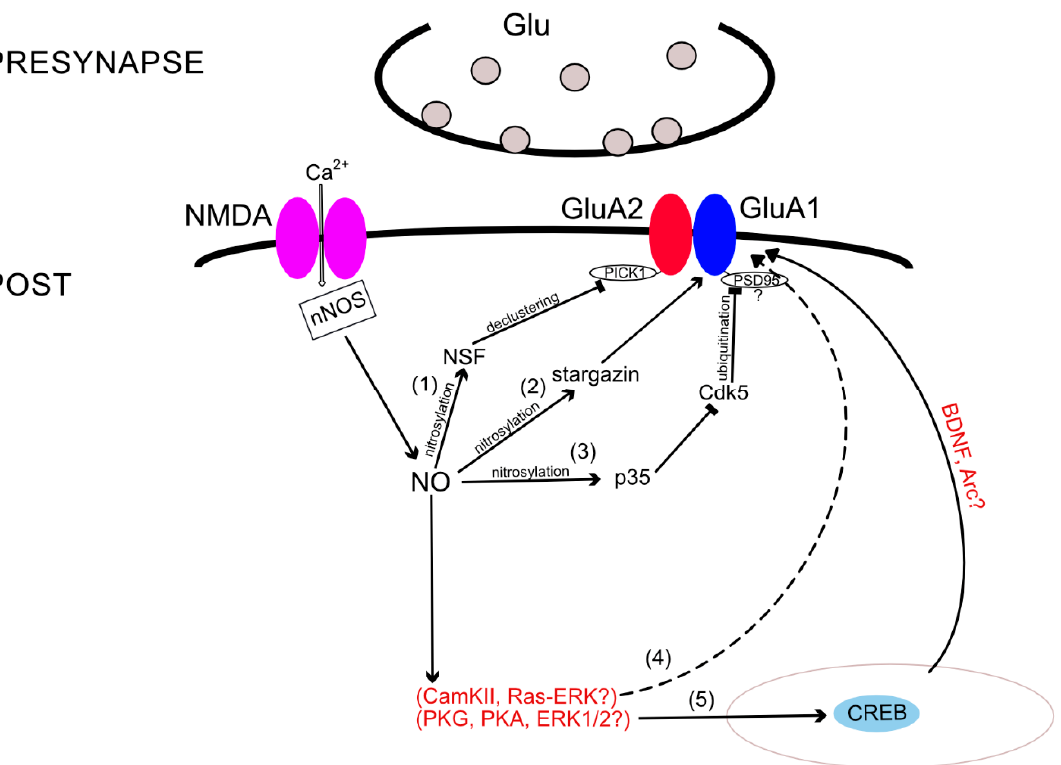
Figure 2. Proposed model of NO-dependent protein–protein interactions underlying GluA1 and GluA2 subunits’ trafficking. Red text and black dashed line represent cascades requiring additional proofs. (1) S -nitrosylation of N -methylmaleimide-sensitive factor (NSF) causes declustering of the protein interacting with C kinase 1) (PICK1)-GluA2 complex, which promotes incorporation in the membrane of GluA2-containing AMPA receptors [84,85]; (2) nitrosylation of stargazin increases its binding to GluA1 and enhances the surface expression of the subunit [96]; (3) NO nitrosylates the p35 protein, leading to a decrease in the activity of the cyclin-dependent kinase 5 (Cdk5) enzyme [98]. This process leads to an increase in the number of GluA1 subunits in the synaptic membrane [100], probably through the ubiquitination of postsynaptic density protein 95 (PSD-95) protein [99]; (4) a potential NO-dependent cascade resulting in the GluA1 insertion. The link between NOS and the Ras-extracellular signal-regulated kinase (ERK) pathway can appear during long-term potentiation (LTP), possibly via Ca 2+ /calmodulin-dependent protein kinase II (CaMKII) activation [117–120]; (5) an additional prospective cAMP response element-binding protein (CREB)-mediated pathway of GluA1 incorporation. NO, through a number of possible proteins, promotes phosphorylation of CREB [105– 107], which, in turn, increases the GluA1 membrane expression [110].